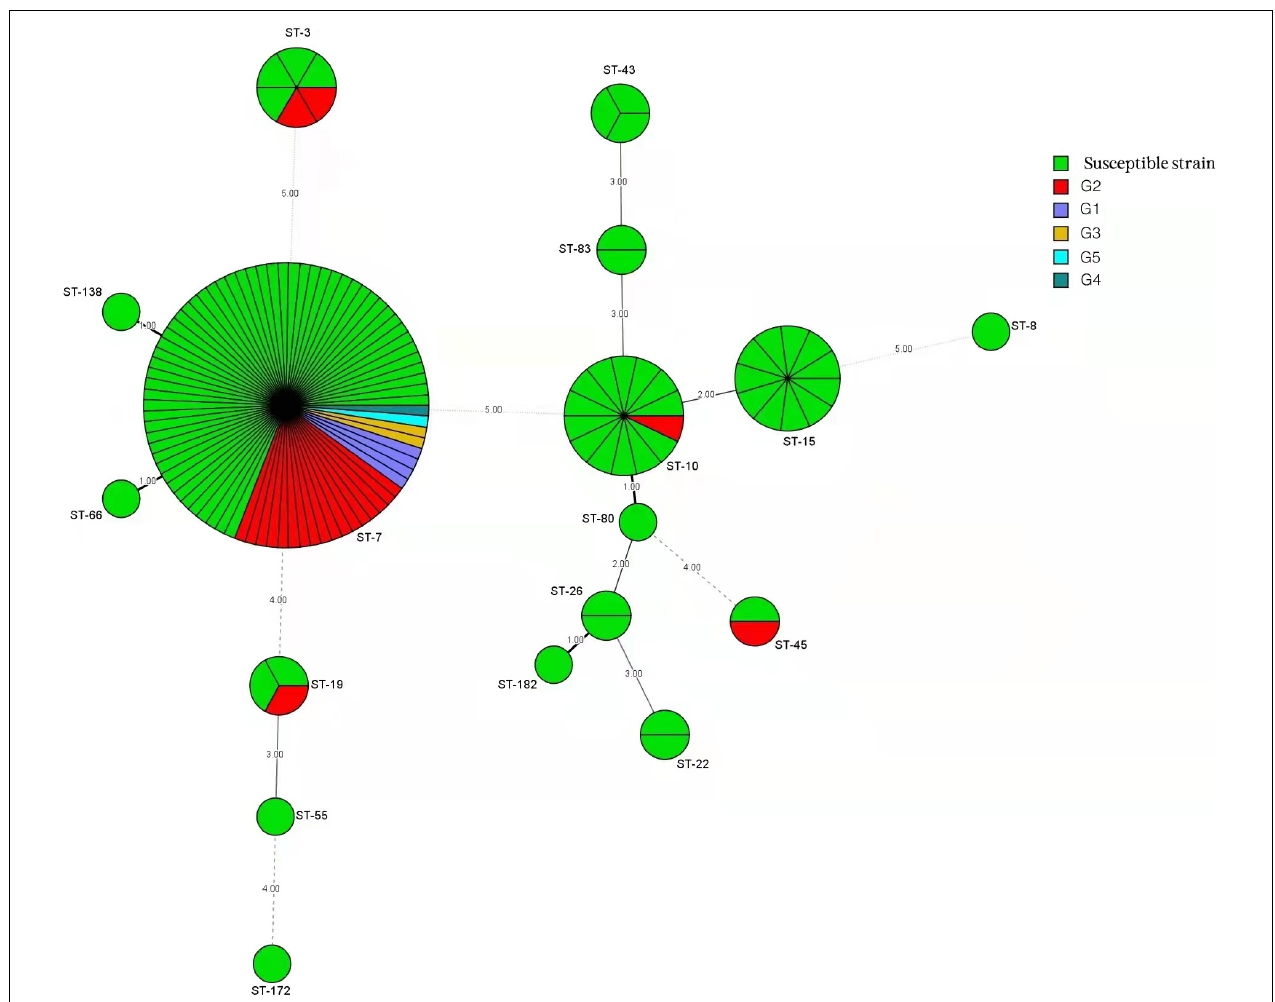
FIGURE 3 | Minimum spanning tree conducted by six housekeeping gene loci of 133 C. glabrata isolates via the BioNumerics software (version 7.6) showing the relationship between the sequence types (STs) and susceptibility patterns of five antifungals tested (fluconazole, itraconazole, voriconazole, amphotericin B, and caspofungin). Each circle corresponds to a ST genotype. The green circles represent a susceptible phenotype, and the other five differently colored circles represent phenotypes comprised of group 1 (G1) to group 5 (G5). The circle size corresponds to the isolate number. Dark, dashed, and thin lines surrounding ST circles represent the genetic